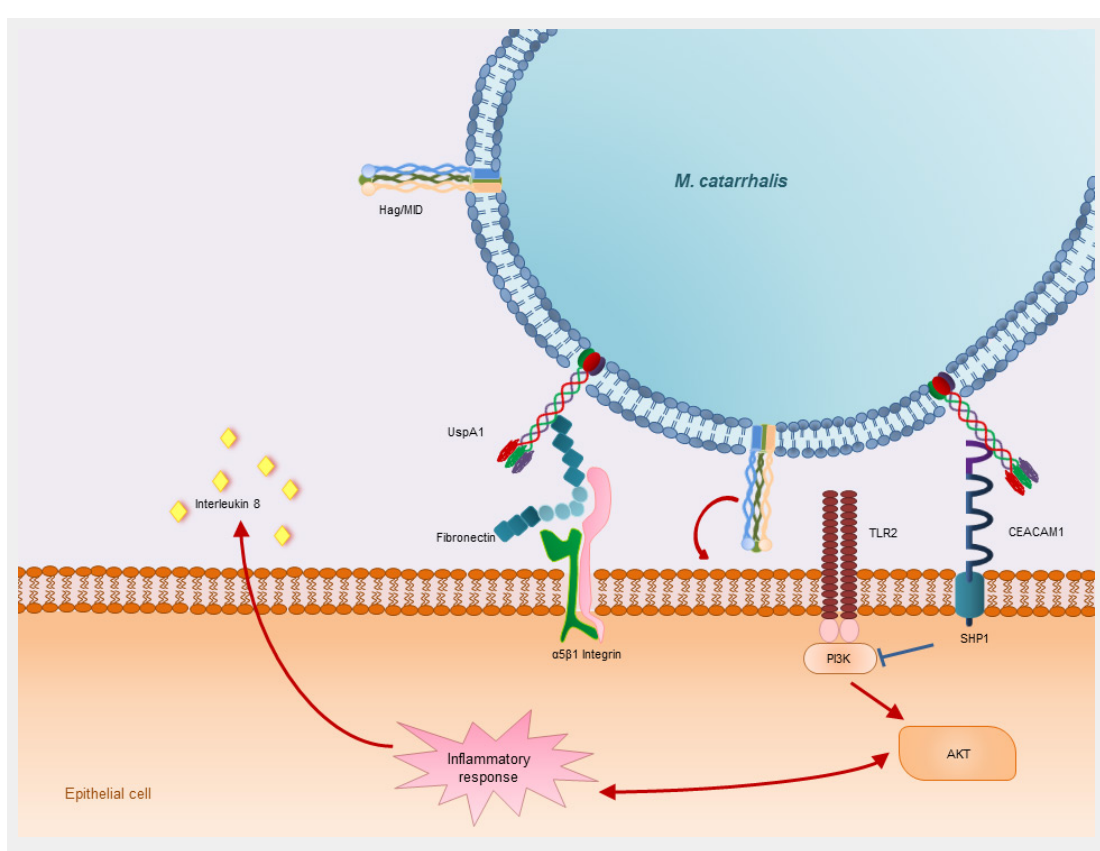
Figure 1 Adherence to host epithelial cells. UspA1 activates the carcino-embryonic antigen-related cell adhesion molecule 1 (CEACAM 1). Binding and activating of CEACAM 1 leads to recruitment of the SH2 containing protein tyrosin phosphatase 1 (SHP1). SHP1 inhibits the phosphoinositide 3-kinase (PI3K) phosphorylation which leads to a suppression of the AKT-mediated pro-inflammatory response. Furthermore UspA1 binds to the extracellular matrix glycoprotein fibronectin which in turn binds to α5β1 Integrin on the surface of the host epithelial cells. Hag/MID is known to be involved in the adherence of M. catarrhalis to host epithelial cells. The exact mechanism and the receptors involved are not yet